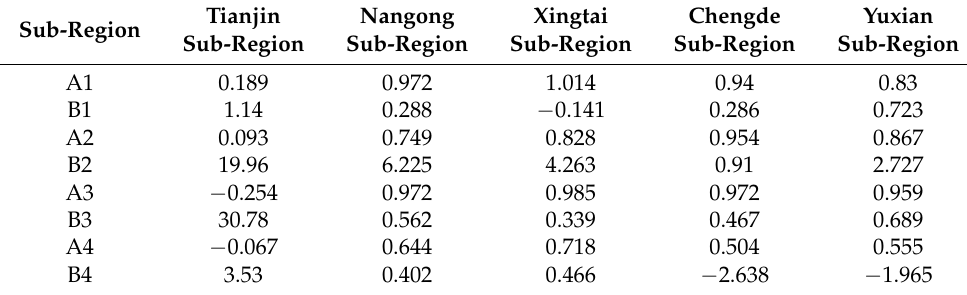
Table 3. Fitting equation coefficients for each region and season in 2002.